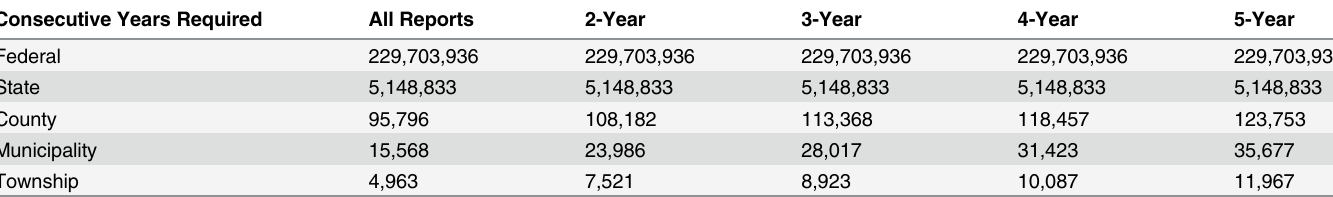
Table 11. The Impact of Requiring Consecutive Data on Average Population.